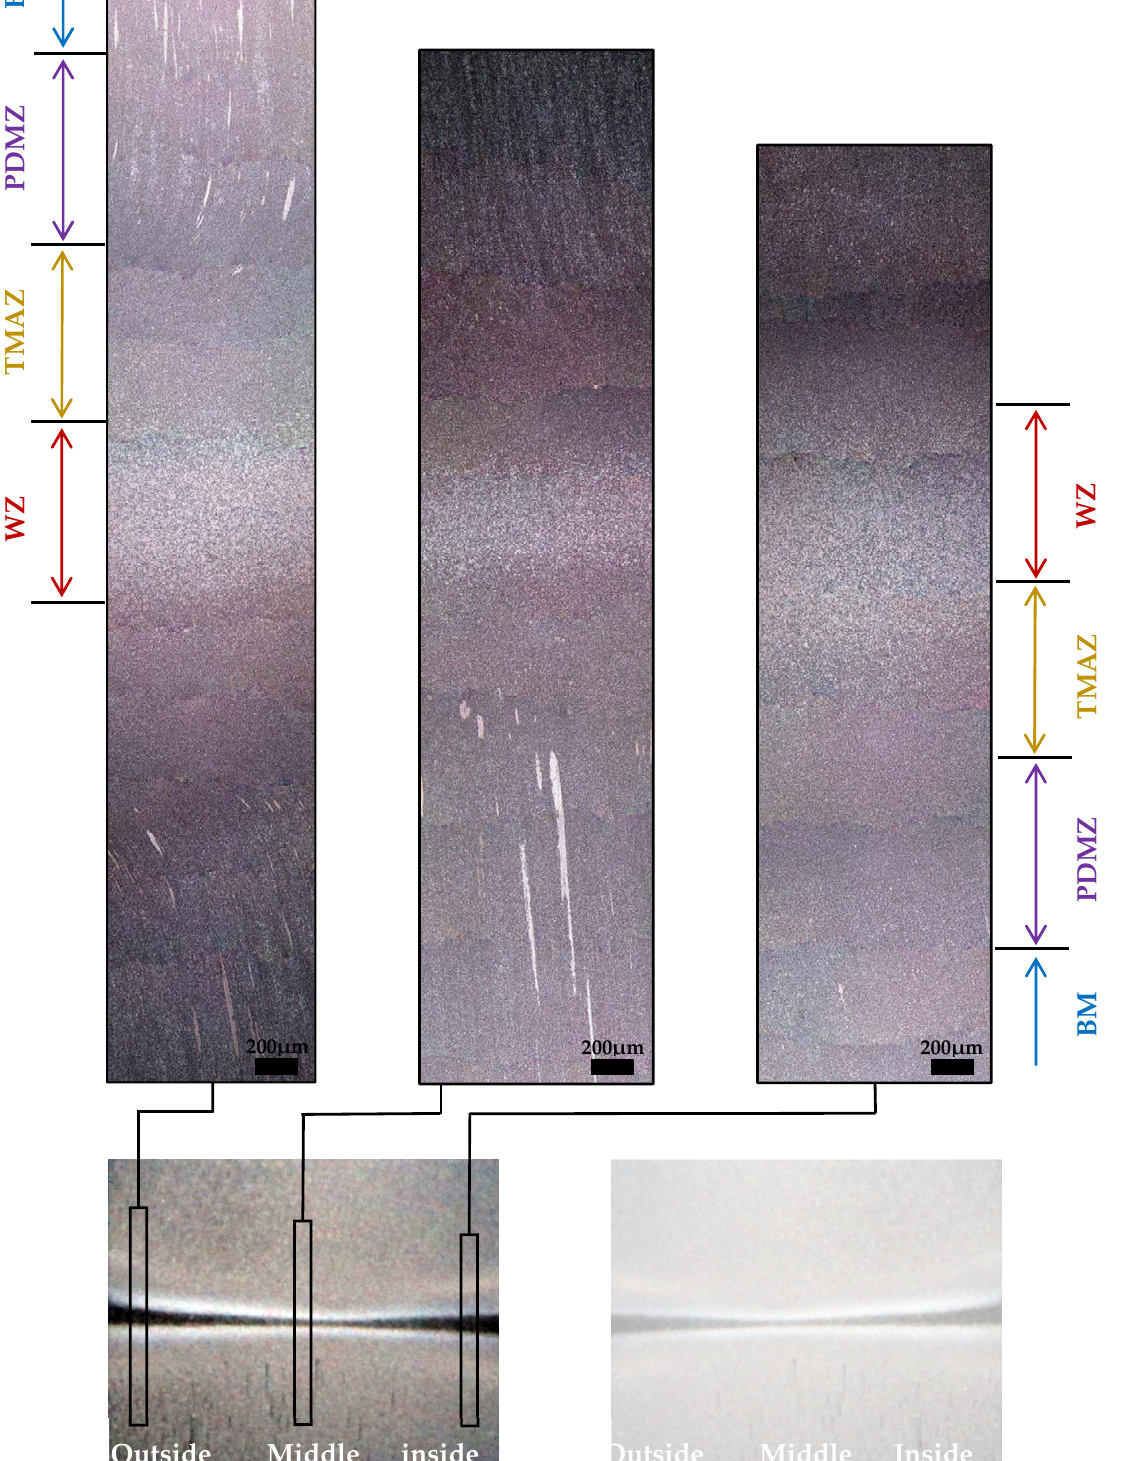
Figure 2. Microstructure distribution of solid solution GH4065A alloy IFW joints.